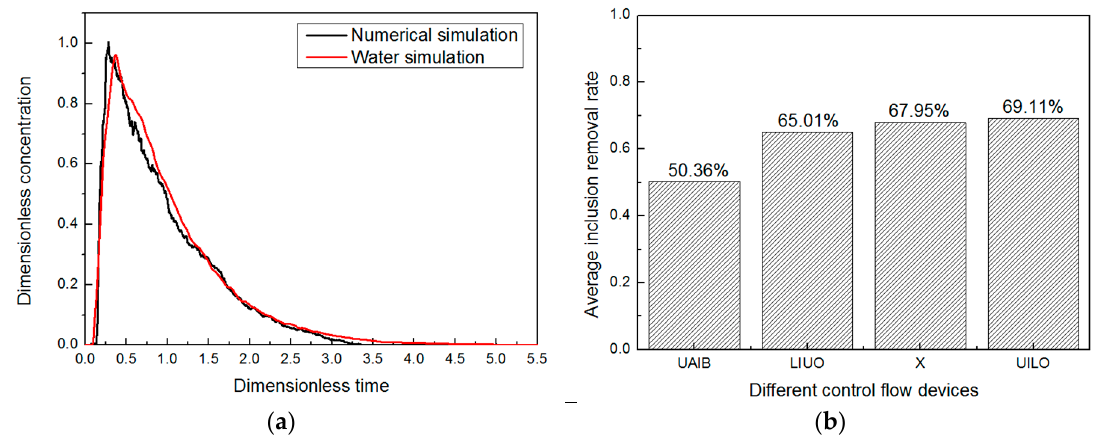
Figure 17. RTD curve and inclusion removal rate in water modeling experiment. ( a ) RTD curve; ( b ) Inclusion removal rate.